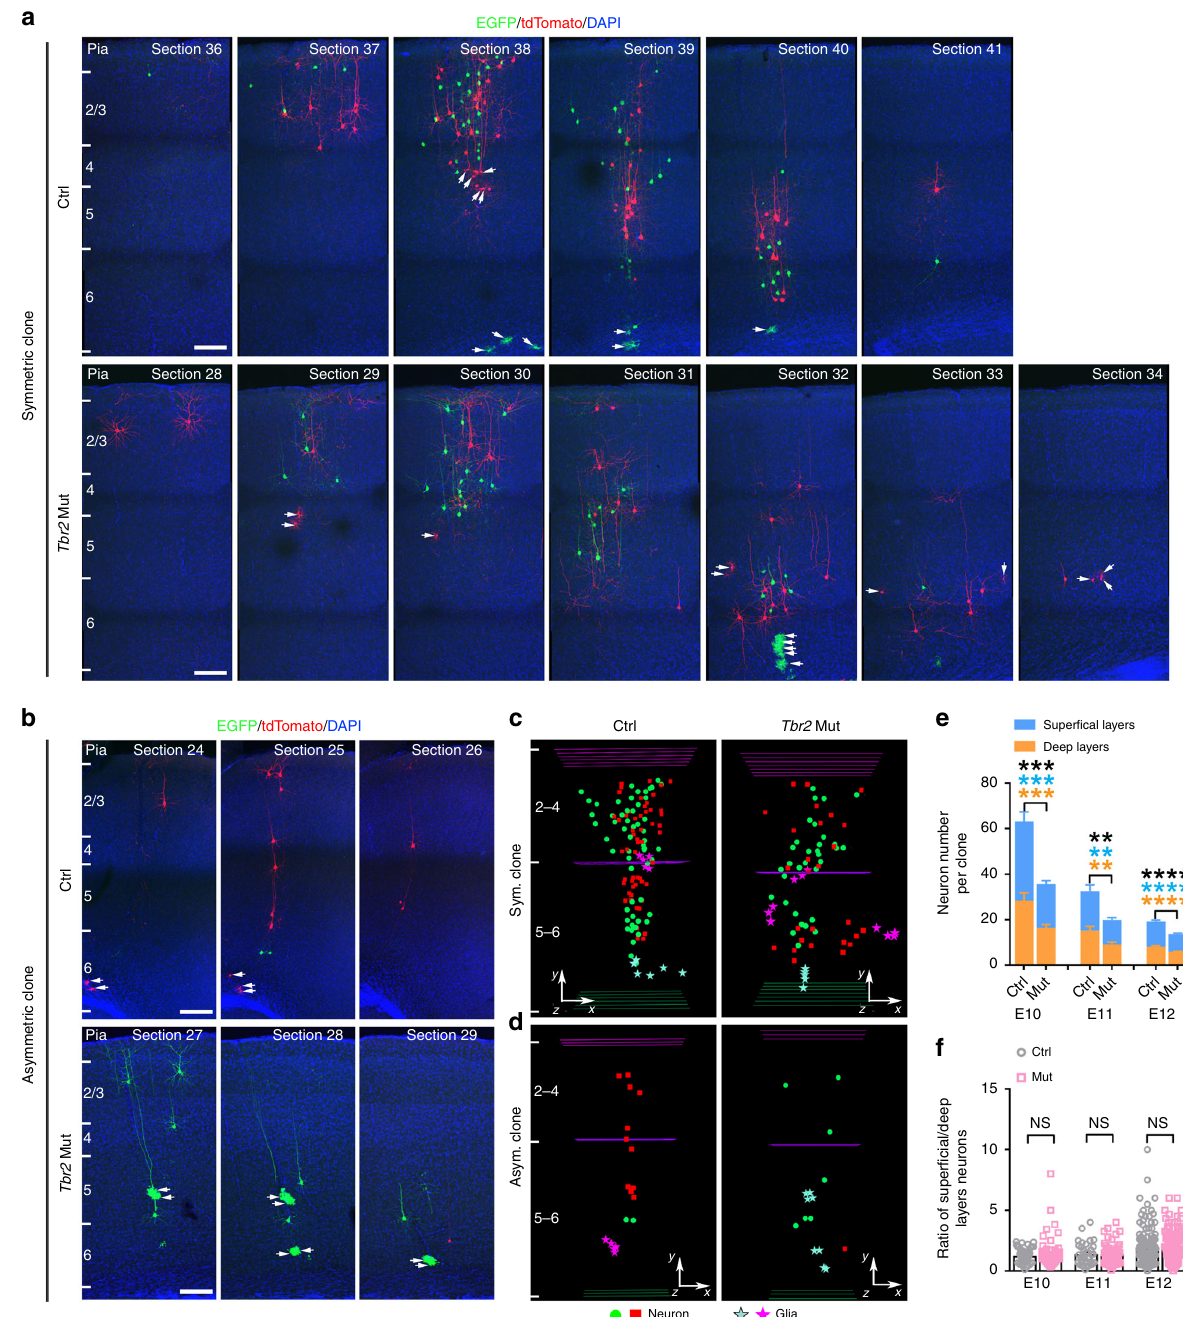
Fig. 1 TBR2 removal causes a reduction in excitatory neuronal output of individual RGPs. a , b Confocal images of representative P21 control (Ctrl) and Tbr2 mutant (Mut) symmetric ( a ) and asymmetric ( b ) MADM clones labeled by tamoxifen administration at E10 and E11, respectively. Consecutive sections were stained for EGFP (green) and tdTomato (red), and counter-stained with DAPI (blue). Arrows indicate glial cells. Scale bars: 100 μ m. c , d 3D reconstruction images of the Ctrl and Tbr2 Mut symmetric and asymmetric clones shown in ( a ) and ( b ). Different colored lines indicate the layer boundaries and different colored symbols represent the cell bodies of labeled neurons and glial cells. The x -/ y -/ z -axes indicate the spatial orientation of the clone with the x -axis parallel to the brain pial surface and y -axis perpendicular to the pial surface. Similar displays are used in subsequent 3D reconstruction images. e Quanti fi cation of the number of neurons in the Ctrl and Tbr2 Mut symmetric and asymmetric clones (E10: Ctrl, n = 63; Mut, n = 78; E11: Ctrl, n = 35; Mut, n = 61; E12: Ctrl, n = 156; Mut, n = 154) labeled at different embryonic stages (E10-E12). Note the signi fi cant reduction in both deep (5 – 6, orange) and super fi cial (2 – 4, blue) layer neurons in the Tbr2 Mut clone compared with the Ctrl clone. Asterisks indicate the statistical signi fi cance of the differences in the number of total (black), deep (orange), or super fi cial (blue) layer neurons in individual clones. Similar displays are used in subsequent fi gures. f Quanti fi cation of the ratio of super fi cial (2 – 4) versus deep (5 – 6) layer neuron numbers in the Ctrl and Tbr2 Mut symmetric and asymmetric clones. Data are presented as mean ± SEM (** P < 0.01; *** P < 0.001; **** P < 0.0001; NS not signi fi cant; unpaired Student ’ s t